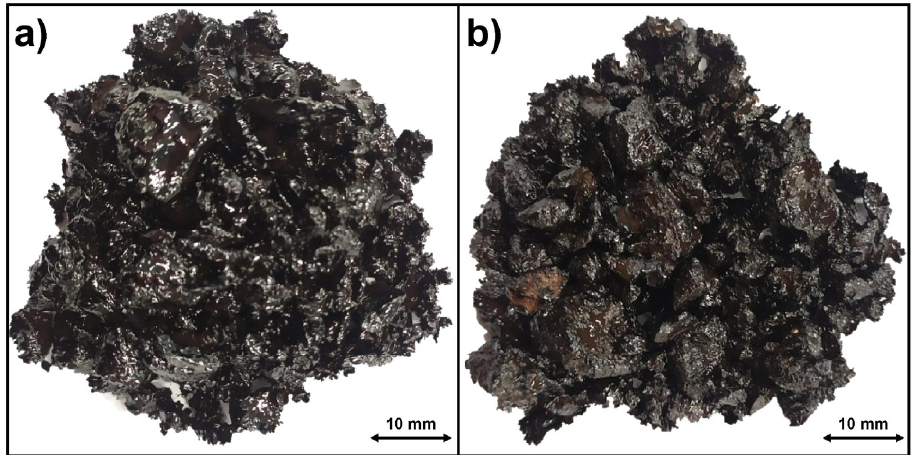
Figure 8. Coating test with the leaching residue and the C60BF3 MBA emulsion. ( a ) Dry coating test and ( b ) coating test after water irrigation.